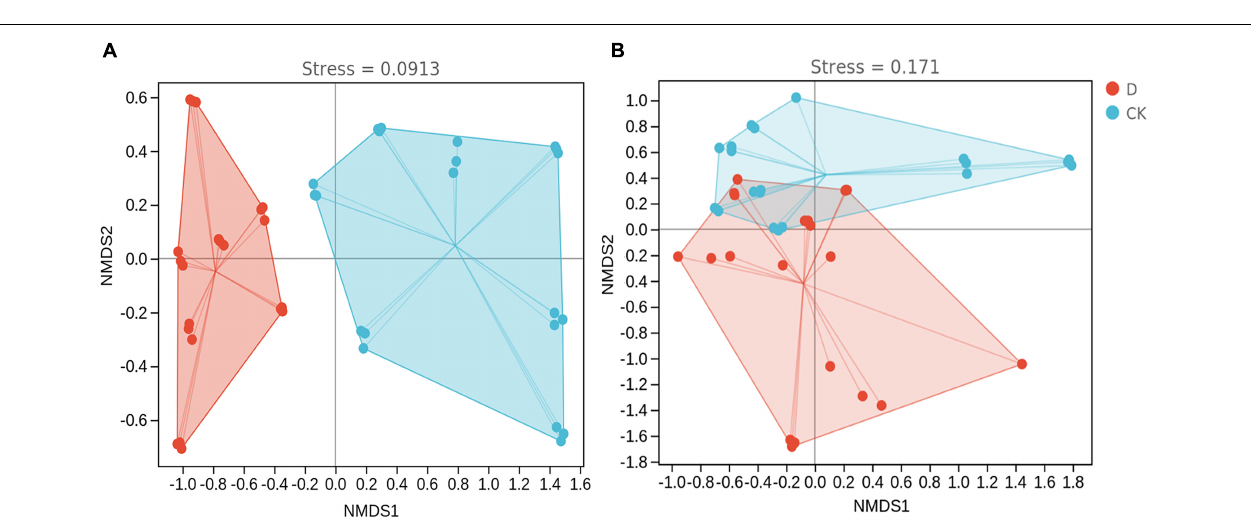
Frontiers in Microbiology |